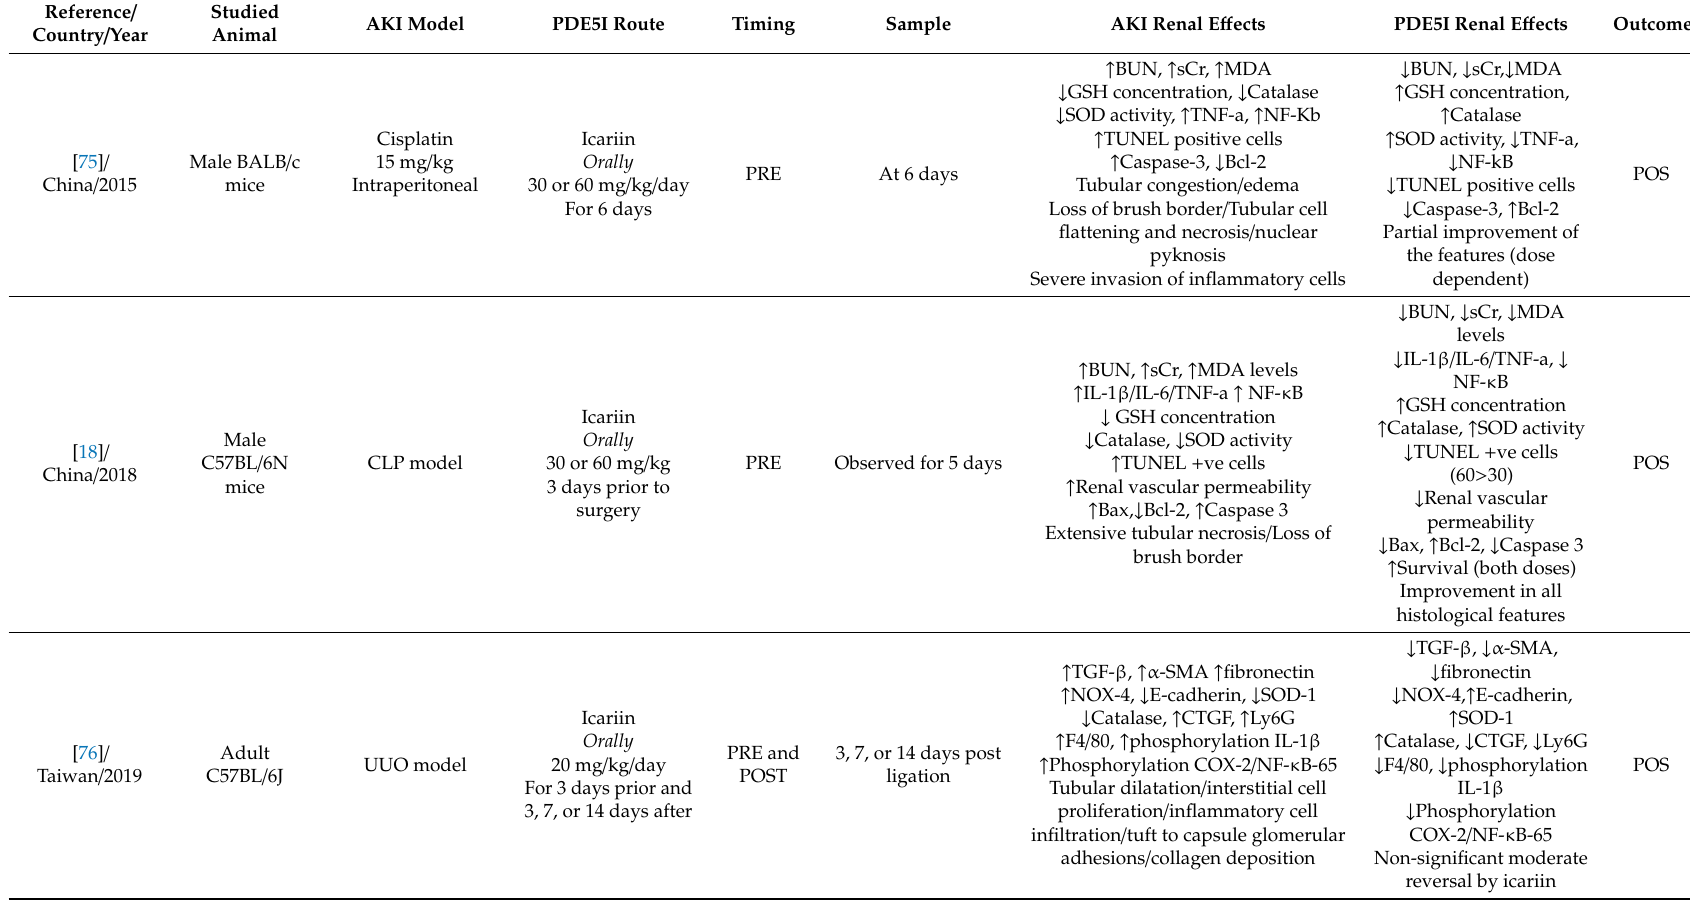
Table 4. Animal studies evaluating the potential reno-protective e ff ects of